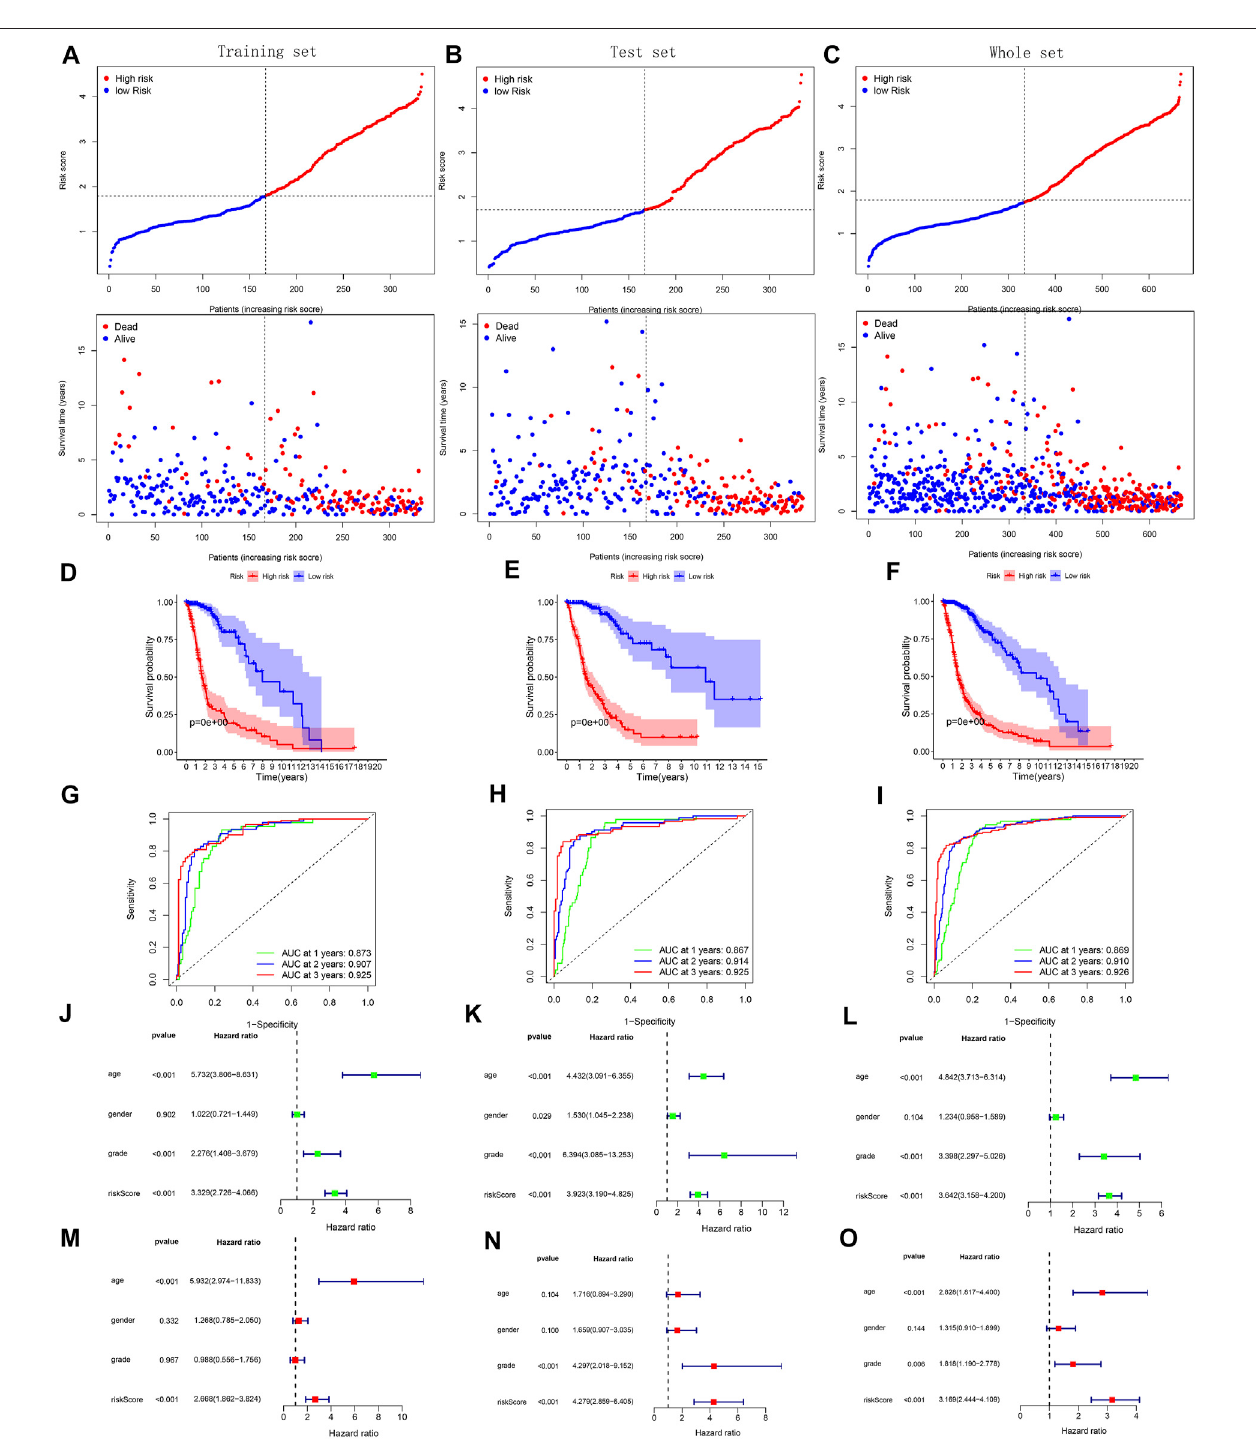
FIGURE 5 | Validation of model ’ s predictive performance using the data of the training, test, and whole set from TCGA. (A – C) Risk curves and survival point plots with increasing risk score. (D – F) Survival curves. (G – I) ROC curves of OS at 1-, 2-, 3-years. AUC > 0.5 is considered to have a predictive value. (J – O) Forest plots re fl ecting the results of univariate and multivariate cox regression analyses.